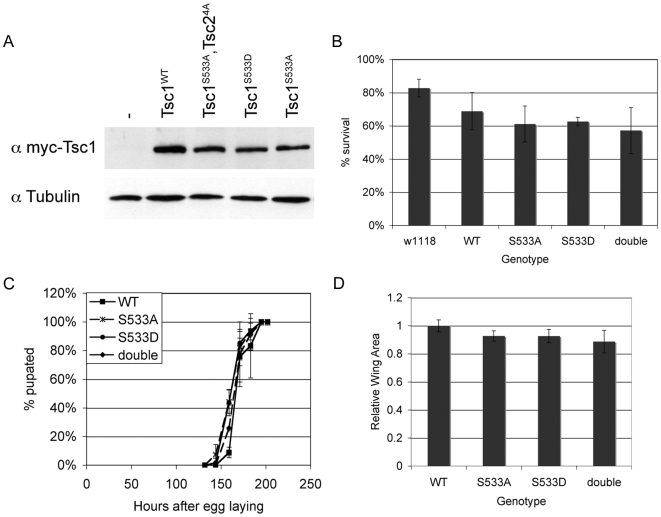
Flies lacking Akt phosphorylation sites on Tsc1 and Tsc2 are viable and normal in size.(A) Expression levels of myc-Tsc1 in fly lines homozygous for the Tsc129 mutation, rescued by ubiquitous expression of Tsc1WT, Tsc1S533A or Tsc1S533D, or flies homozygous for both the Tsc129 and Tsc2192 mutations rescued to viability by ubiquitous expression of both Tsc1S533A and Tsc2T437A/S924A/T1054A/T1518A (“Tsc1S533A,Tsc24A”). (B,C,D) Survival rates (B), pupation curves (C) and relative adult wing sizes (D) of animals seeded as L1 larvae under controlled growth conditions for genotypes w1118 (“w1118”), Tsc129 homozygotes rescued by ubiquitous expression of Tsc1WT (“WT”), Tsc1S533A (“S533A”) or Tsc1S533D(“S533D”), or flies homozygous for both the Tsc129 and Tsc2192 mutations rescued to viability by ubiquitous expression of both Tsc1S533A and Tsc2T437A/S924A/T1054A/T1518A (“double”).